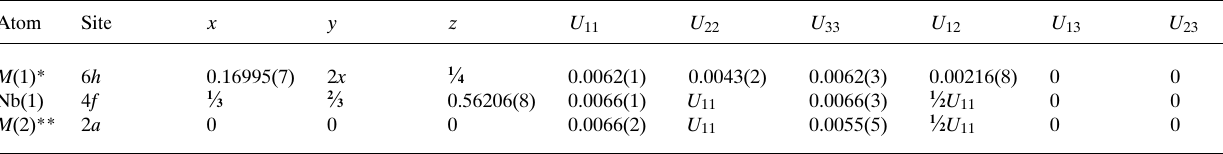
Table 2. Atomic coordinates and displacement parameters (in Å 2 )